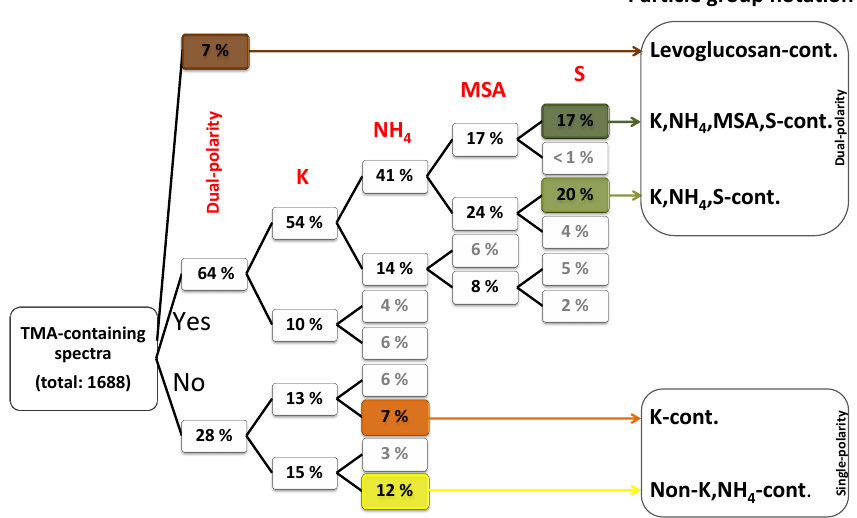
Figure 9. Classification of TMA-containing particles on the basis of their different internal mixing states. Each branch describes the existence or non-existence of several substances (potassium (K), ammonium (NH 4 ), MSA and sulfate) on TMA-containing particles with relative abun- dances normalized to the occurrence of 1688 TMA-containing particles. An initial query regarding the existence of dual-polarity spectra is in- cluded. Based on this classification, four TMA-containing particle sub-types arise (colored boxes with relative fractions): “K,NH 4 ,MSA,S-”, “K,NH 4 ,S-”, “K-” and “Non-K,NH 4 -containing”. We further considered an internal mixing of particulate TMA with levoglucosan (7%), Na / Cl and EC (not listed here), whereby the latter two types with relative fractions of less than 1% are negligible for further analysis. Gray-shaded numbers indicate groups with relative fractions of less than 7% that are not further